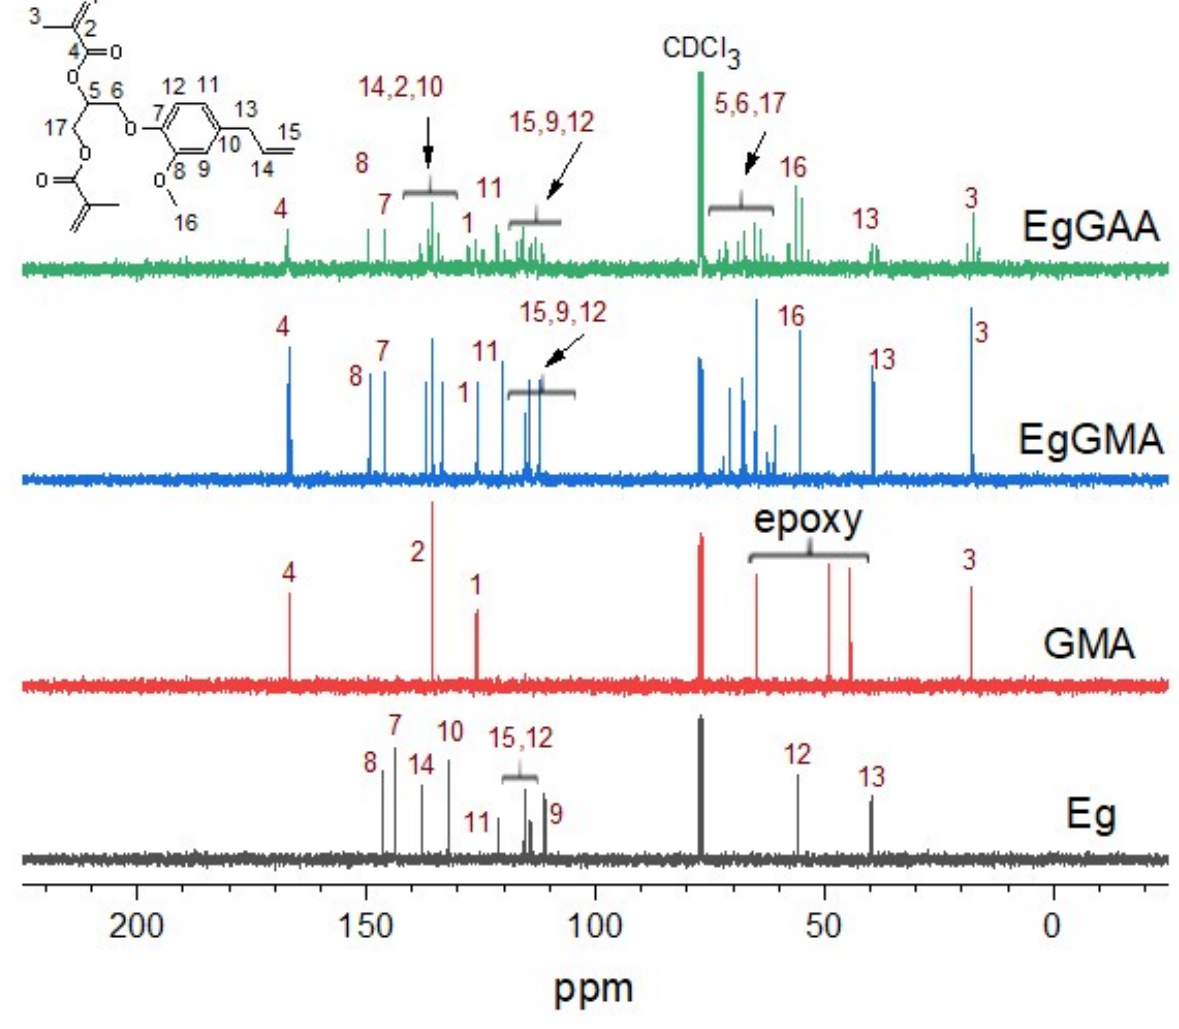
Figure 4. 13 C NMR spectra of Eg, GMA, EgGMA, and EgGAA. Peaks were numerically marked as in the included structure.